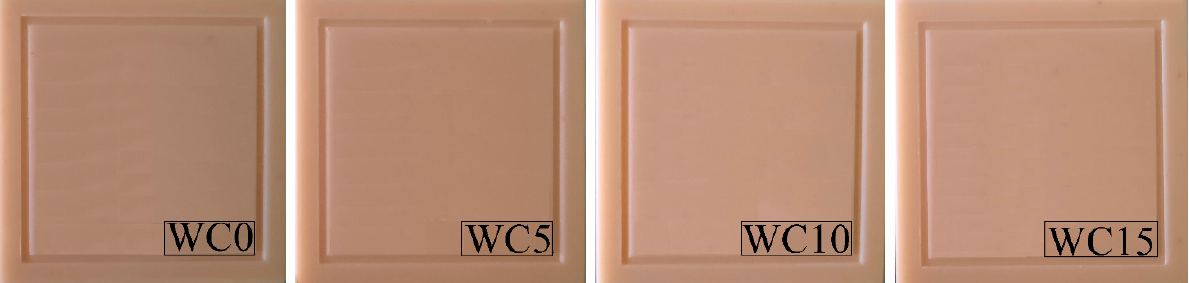
Figure 3. Photograph of white chocolate and white chocolates with RS.